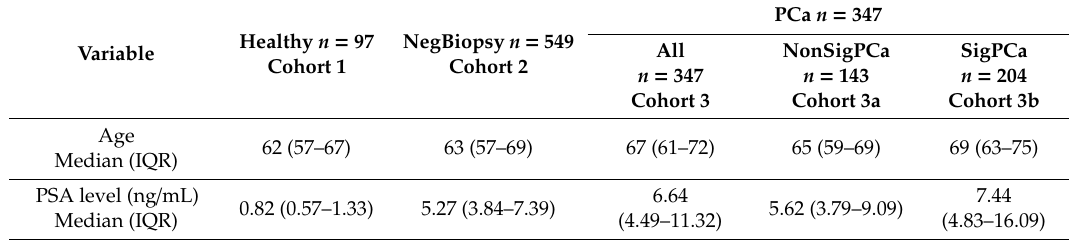
Table 1. Clinical and anatomopathological data of the three cohorts of patients included in this